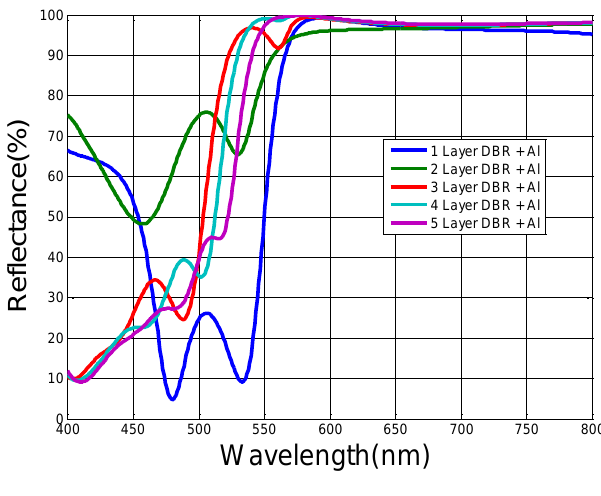
Figure 5. Reflectance characteristics for structures with the different number of DBR layers, with an added SiO phase matching layer and aluminum 2